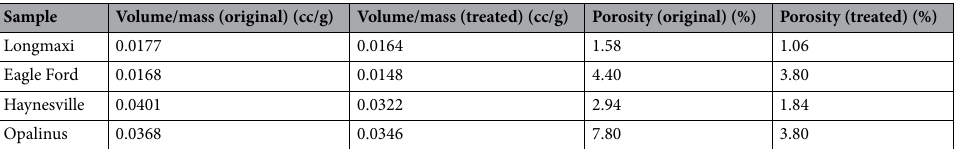
Table 3. Variation in porosity between original and treated